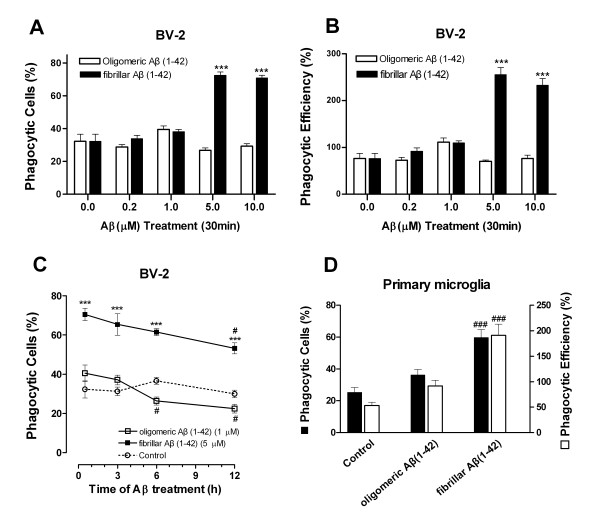
Effects of oligomeric versus fibrillar Aβ(1-42) on phagocytic function of microglial cells. (A) Dose dependence of phagocytosis stimulated by oAβ(1-42) and fAβ(1-42). BV-2 cells were incubated with the indicated Aβ(1-42) (0.2~10 μM) for 30 min before being exposed to microspheres for an additional 30 min; (B) The number of microspheres taken up per BV-2 cell with or without oAβ(1-42) or fAβ(1-42) treatment; (C) Time course of phagocytosis stimulated by oAβ (1-42) or fAβ(1-42) in microglial cell. BV-2 cells were preincubated with oAβ(1-42) (1.0 μM) or fAβ(1-42) (5.0 μM) for 30 min, 3 h, 6 h,12 h before the addition of microspheres for 30 min. (D) Phagocytosis stimulated by oAβ(1-42) or fAβ(1-42) in primary microglia. Cells were incubated with the oAβ(1-42) (1.0 μM) or fAβ(1-42) (5.0 μM) for 30 min before the addition of microspheres. Each value is expressed as mean ± S.E. of three independent experiments. ***P < 0.001, compared with the oAβ-treated groups. #P < 0.05, compared with the 30 min treated groups.